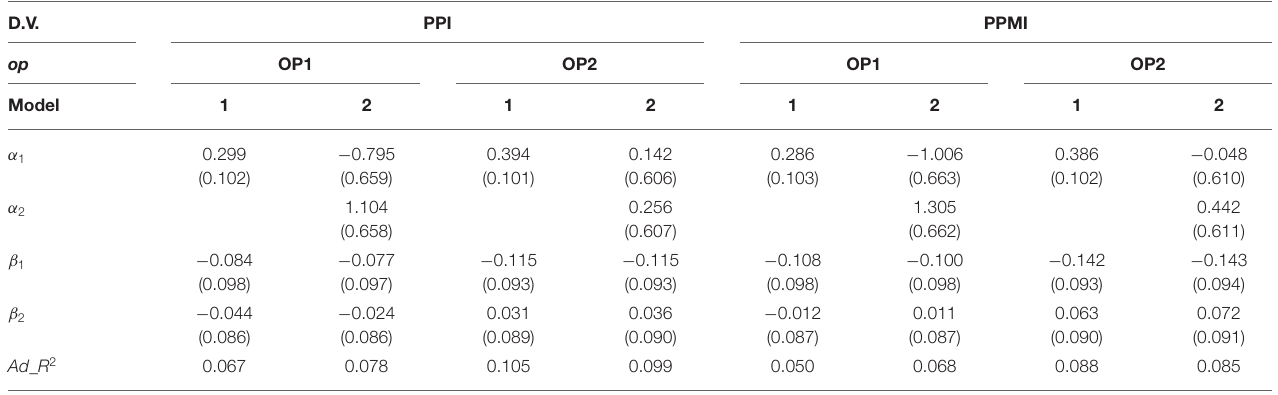
TABLE 5 | The relationships between oil prices and producer prices. D.V.